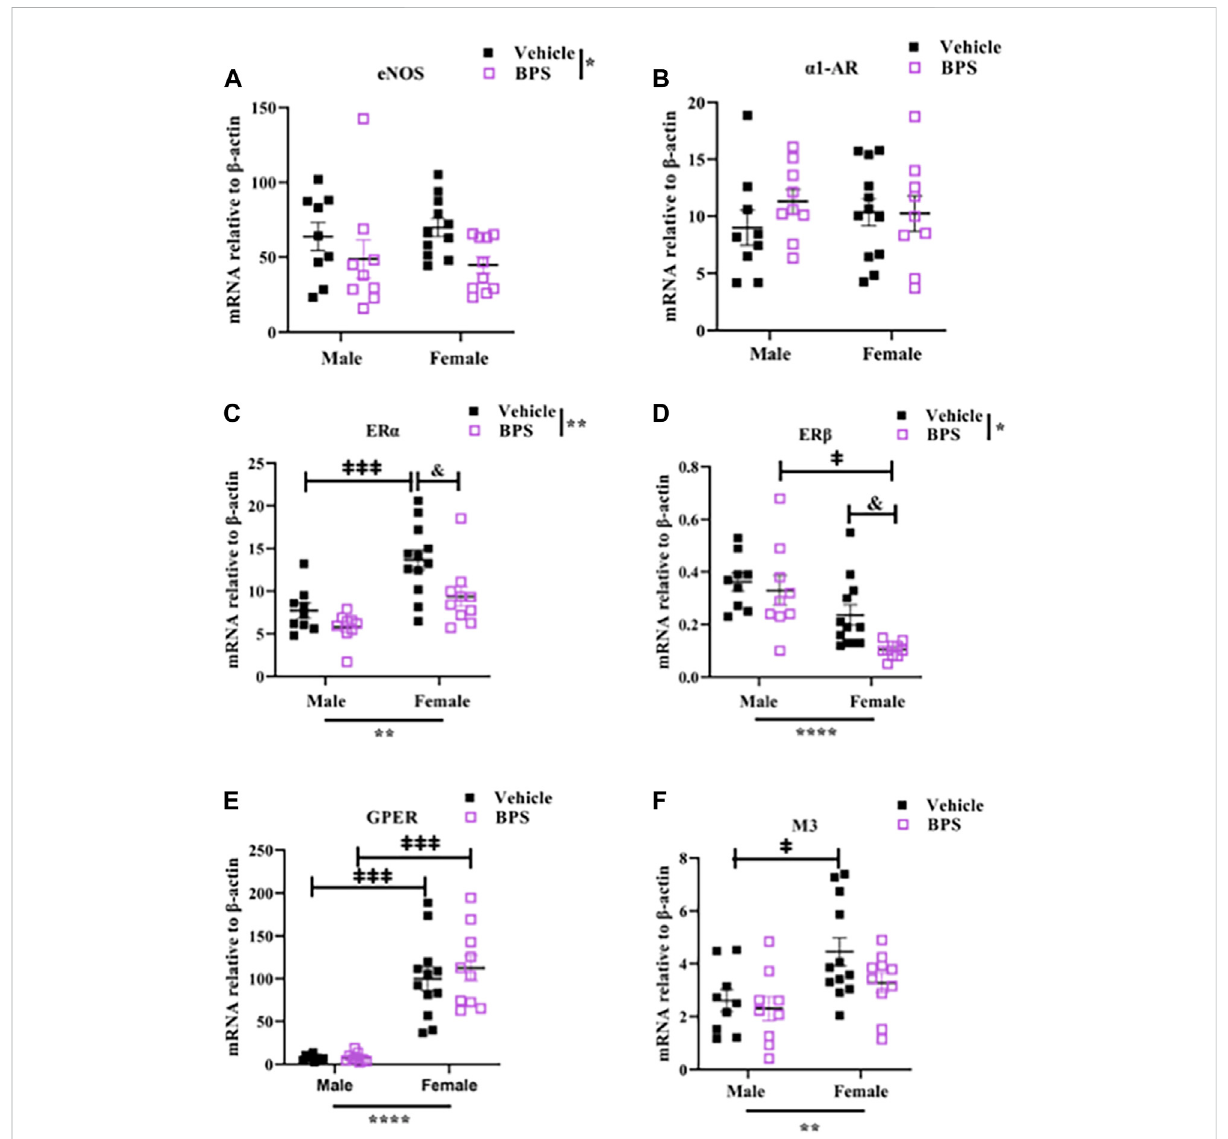
FIGURE 4 Gestational BPSexposure decreasesmRNA expressionof eNOS,ER α ,and ER β inmicrovessels. qRT-PCRwas usedto measuregene expression relative to β -actin in mesenteric vessels isolated from vehicle or BPS-exposed mice. (A – F) mRNA levels of eNOS, α 1-AR (Phe receptor), ER α , ER β , GPER and M3 (ACh receptor). Two-way ANOVA was used to determine the impact of treatment (BPS) or sex on gene expression. * p < 0.05; ** p < 0.01 treatment or sex as a signi fi cant source of variation. & p < 0.05 BPS vs. vehicle by Sidak ’ s multiple comparison test. ‡ p < 0.05; ‡‡‡ p < 0.001; male vs. female by Sidak ’ s multiple comparison